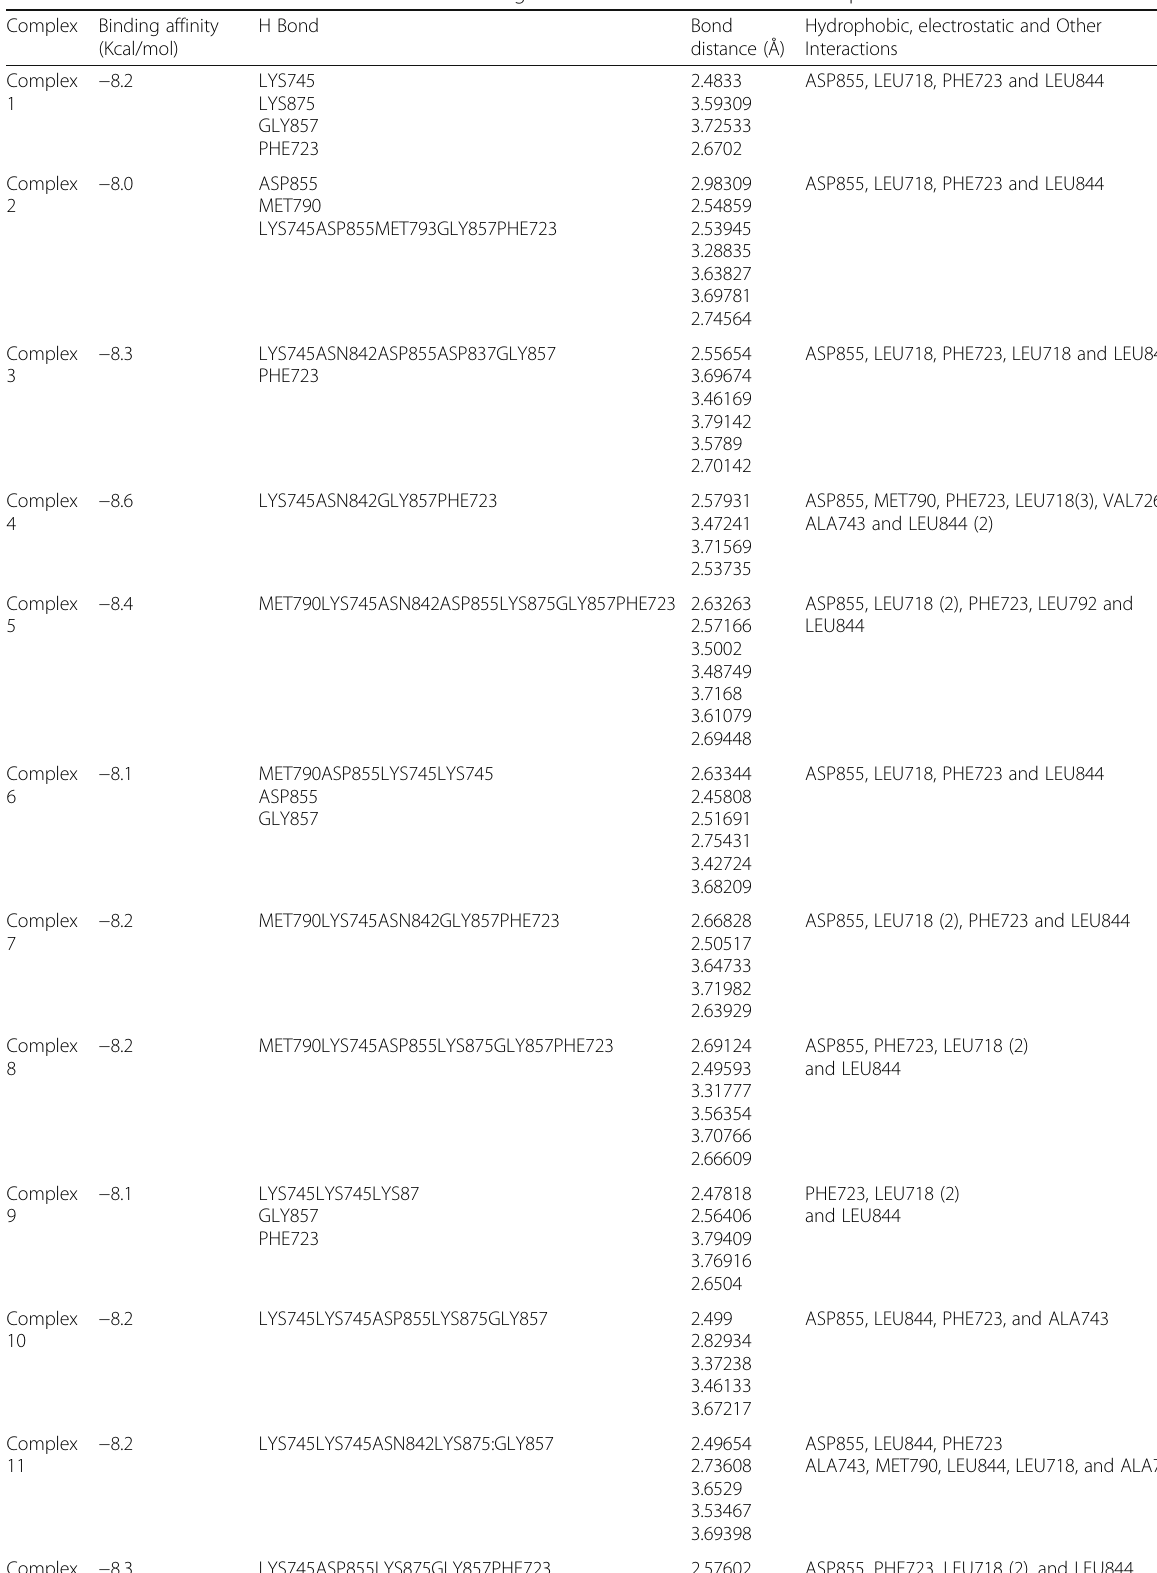
Table 2 The interactions of the molecules under investigation in the active site of EGFR